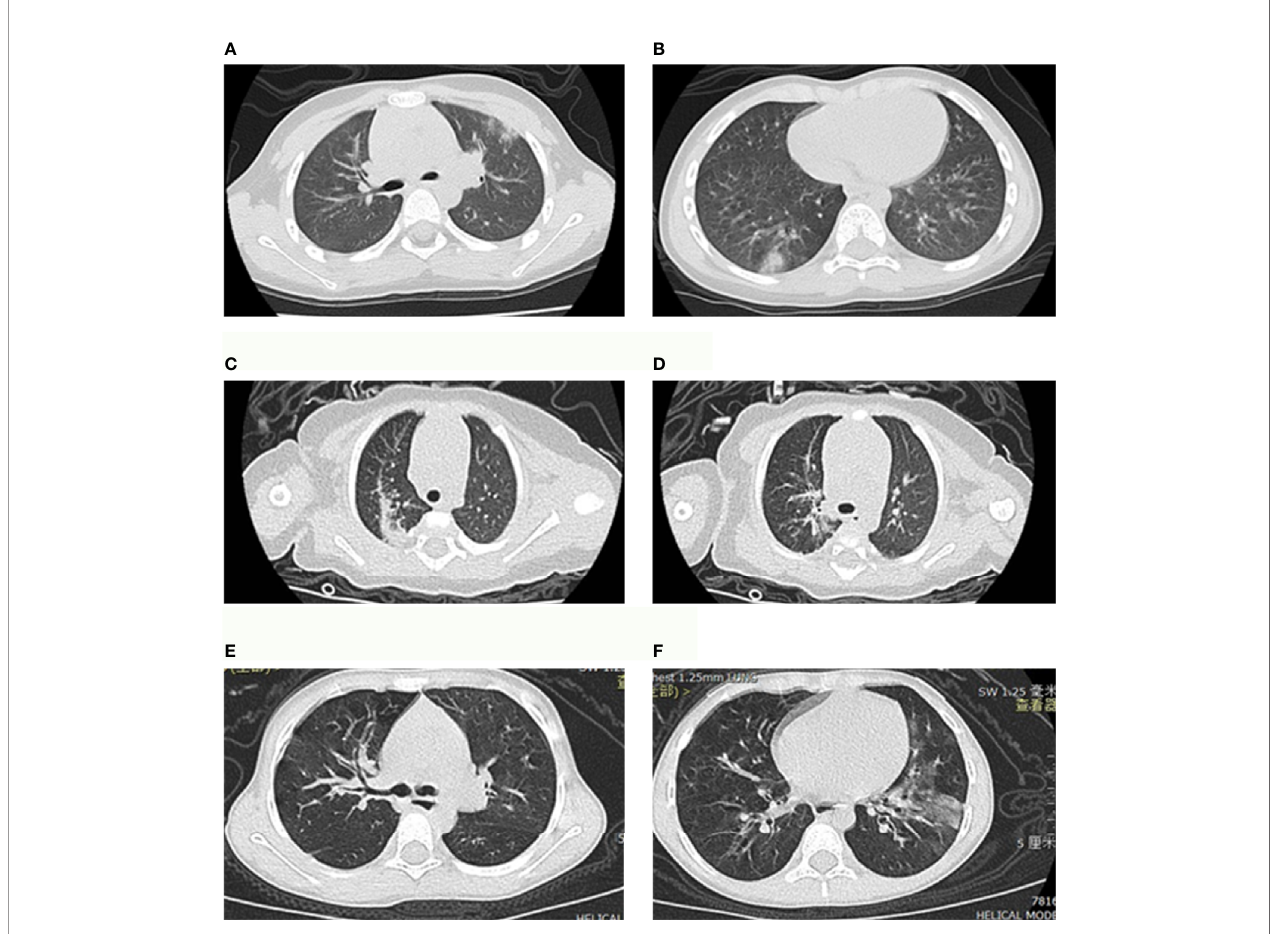
FIGURE 2 | Chest computed tomography (CT) scans for COVID-19 pneumonia patient and Non-COVID-19 viral pneumonia patients. (A, B) showed ground-glass opacities were located in the right lower lobe of the lung and upper lobe of the left lung and located under the pleura in a patient with COVID-19 pneumonia. (C, D) showed multiple patchy shadows and consolidation in two lungs in a patient with respiratory syncytial virus (RSV) pneumonia. (E, F) showed thickened tracheobronchial wall in right lung and ground-glass opacities were located in the left lower lobe of the lung in a patient with in fl uenza A (IFA)